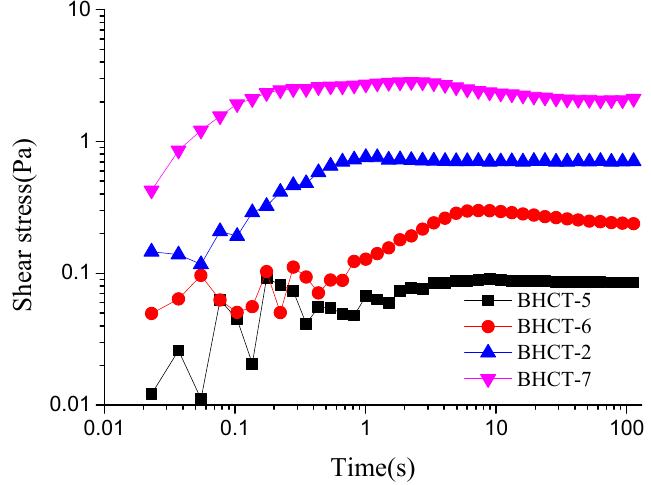
Figure 17. Time-dependent apparent shear stress of composite gels under di ff erent bentonite contents. Table 5. Maximum shear stress of composite gel under di ff erent bentonite content.